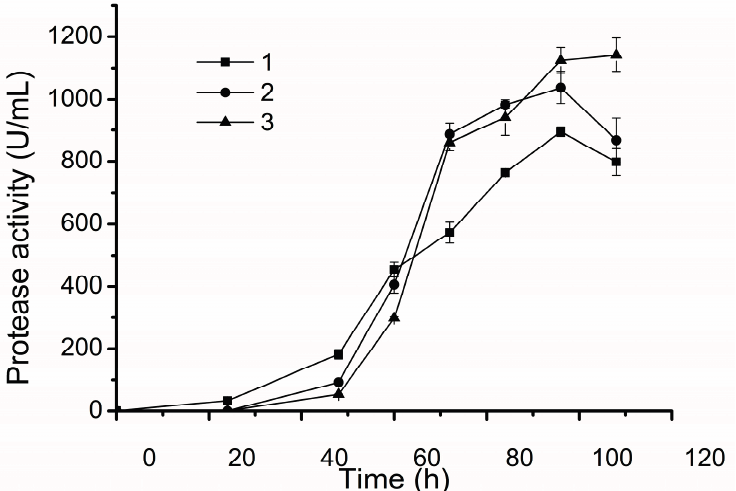
Figure 5. The protease activity of the D25 broth of the pilot scale fermentation under different conditions. Line 1, the protease activity of the fermentation broth with the aeration rate of 1 m 3 /h and the stirring speed of 90 rpm. Line 2, the protease activity of the fermentation broth with the aeration rate of 2 m 3 /h and the stirring speed of 80 rpm. Line 3, the protease activity of the fermentation broth with the aeration rate of 2 m 3 /h and the stirring speed of 90 rpm. The graph shows data from triplicate treatments (mean ±